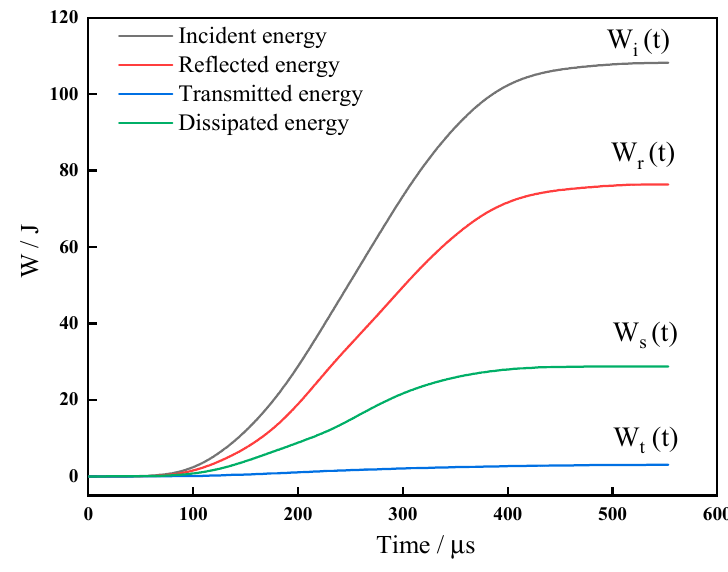
Figure 8. Energy variation of a specimen with time in a dynamic splitting test. To avoid lengthy space, to achieve the research purpose, only S1PP0.2 concrete and PC with the best splitting performance can be used for energy analysis. Figure 9 shows the time history curve of dynamic splitting dissipation energy of PC and S1PP0.2 concrete in different temperature groups. It can be seen from the figure that the dynamic splitting dissipation energy of concrete materials increases first and then decreases with the increase of temperature. Compared with PC, the energy dissipation effect of S1PP0.2 concrete at the same temperature is significantly improved, and the variation law of HFRC dissipation energy and splitting strength with temperature is